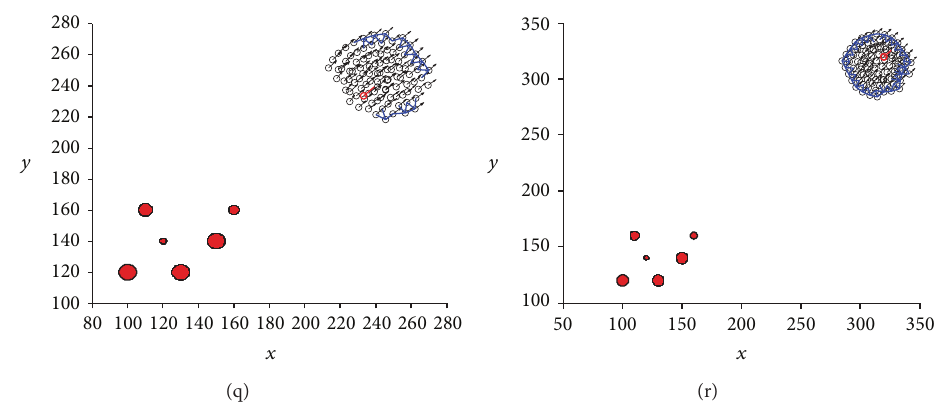
Figure 6: Simulation process of the proposed FMOA algorithm with avoiding obstacles.